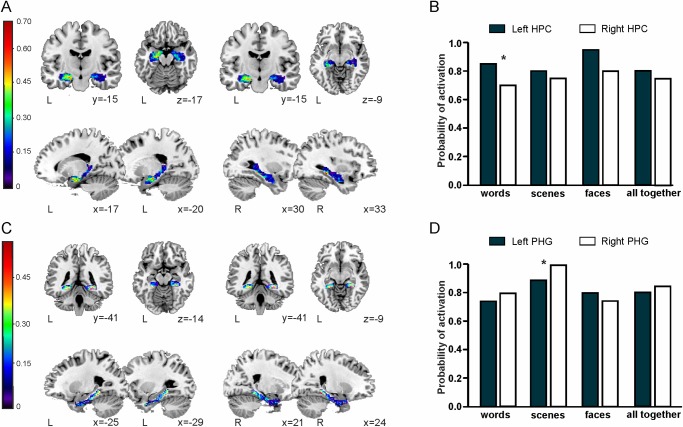
MTL ROI analysis.
A. Spatial distribution of HP activations at the individual level. Each voxel represents the percentage of subjects in which a novelty effect was found in any of the three encoding conditions (words, faces, scenes) at the individual level (in a particular subject a voxel is counted as activated if any of the three types of stimuli yields an activation above the selected p < 0.05 threshold with 5 voxels of spatial extent). B. Percentage of participants that showed significant (p < 0.05 uncorrected at the subject level) novelty-related activations in any group of at least 5 contiguous voxels inside the HP ROI. The percentages are reported for each stimulus separated (words, faces, scenes) and for all stimuli pooled together. C. Spatial distribution of PHG activations at the individual level. Each voxel represents the percentage of subjects in which a novelty effect was found in any of the three encoding conditions (words, faces, scenes) at the individual level (in a particular subject a voxel is counted as activated if any of the three types of stimuli yields an activation above the selected p < 0.05 threshold with 5 voxels of spatial extent). D. Percentage of participants that showed significant (p < 0.05 uncorrected at the subject level) novelty-related activations in any group of at least 5 contiguous voxels inside the PHG ROI. The percentages are reported for each stimulus separated (words, faces, scenes) and for all stimuli pooled together. Colour-coded scale indicates the percentage of participants that showed activation at the individual level in a particular voxel in any of the three tasks. Spatial maps are overlaid over a canonical template with MNI coordinates at the bottom right of each slice. * Significant (p < 0.05) difference in amount of voxels activated between the left and right ROI (see Methods and Results).